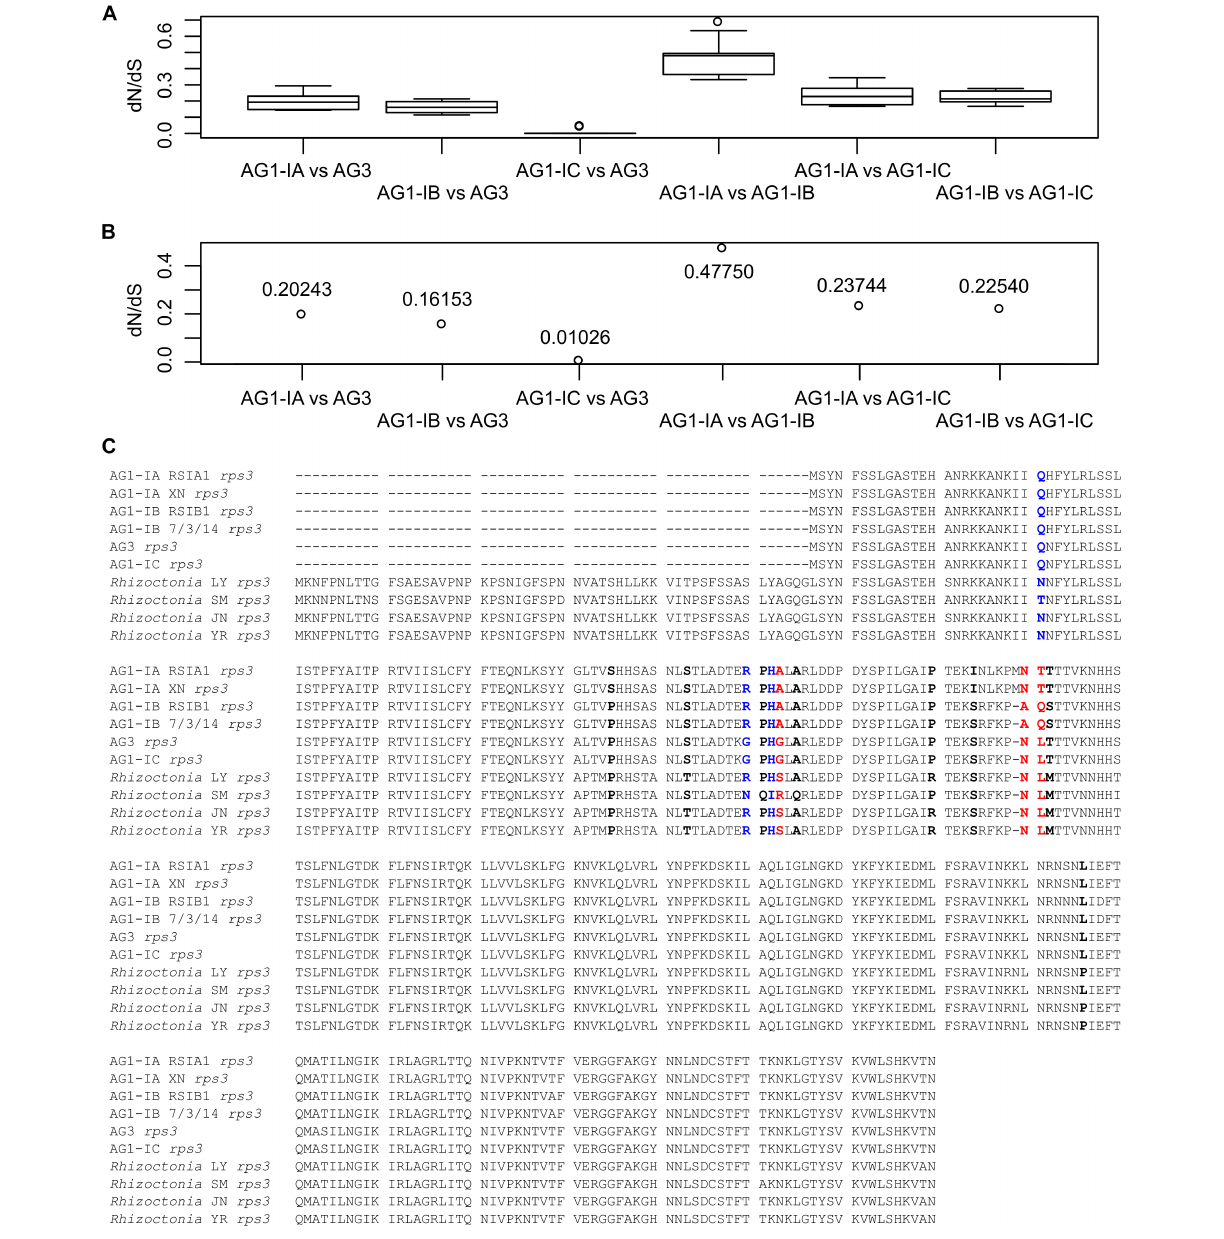
and cox3 from AG1-IA were clustered into three